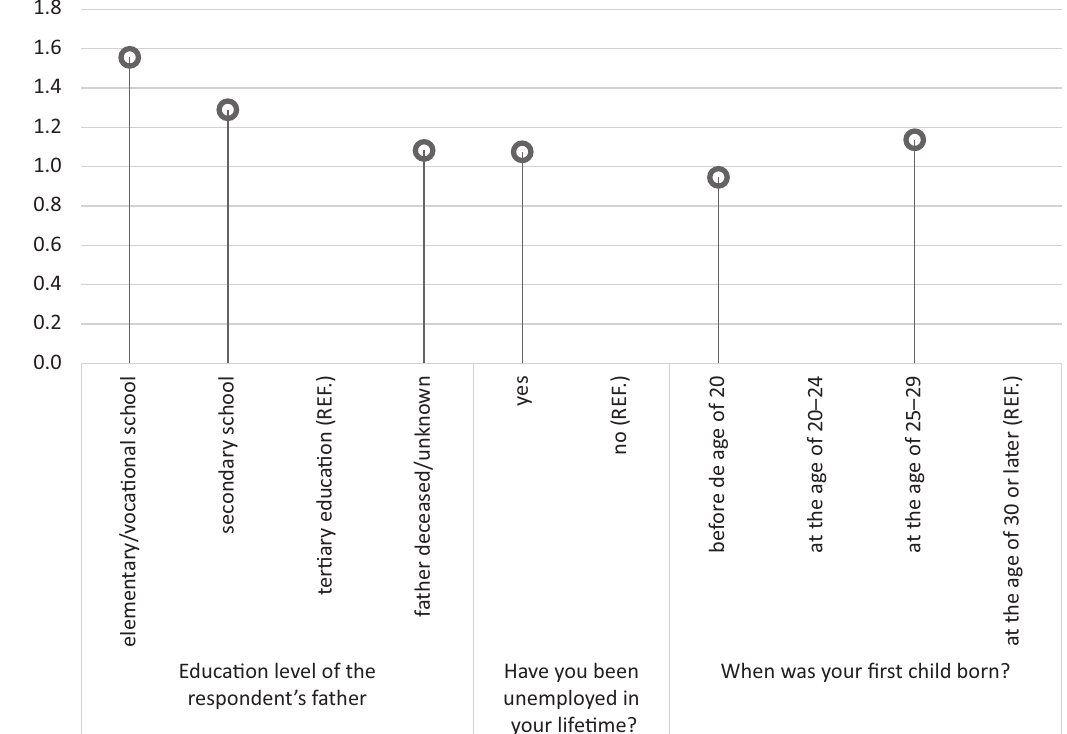
Figure 5. Life‐course characteristics that determine the three‐generation living arrangement, 2016 (results of the logistic regression models, odds ratios). Notes: Individual‐level data; all effects are significant at the p < 0.001 level.